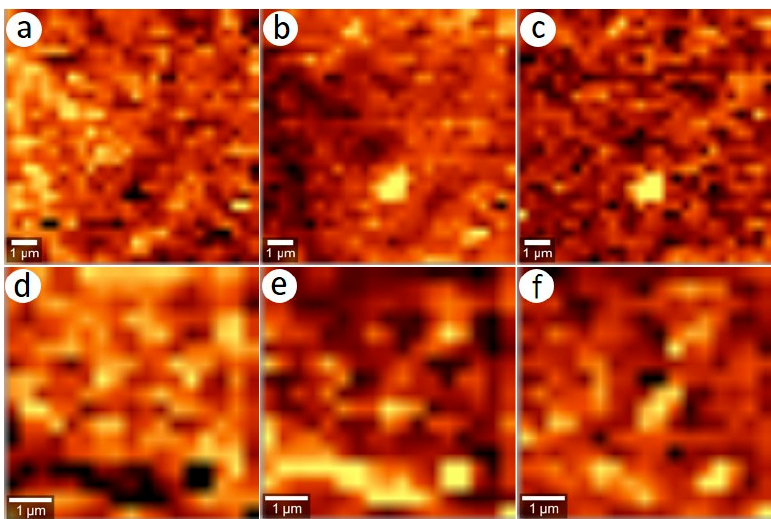
Figure 4. Raman maps for chalcopyrite samples leached in the presence of ferrous at 14 ( a – c ) and 42 days ( d – f ). ( a ) and ( d ) 272 cm − 1 ; ( b ) and ( e ) 294 cm − 1 ; ( c ) and ( e ) 355 cm − 1 .